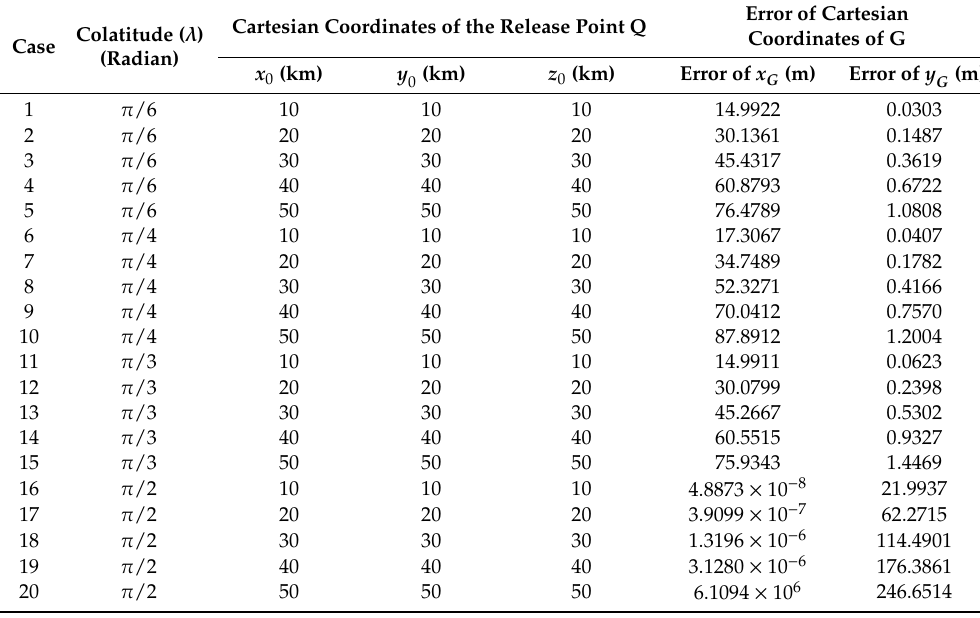
Table 3. The obtained errors of x G and y G at several release points Q ( x 0 , y 0 , z 0 ) when λ = π /6, π /4, π /3, π